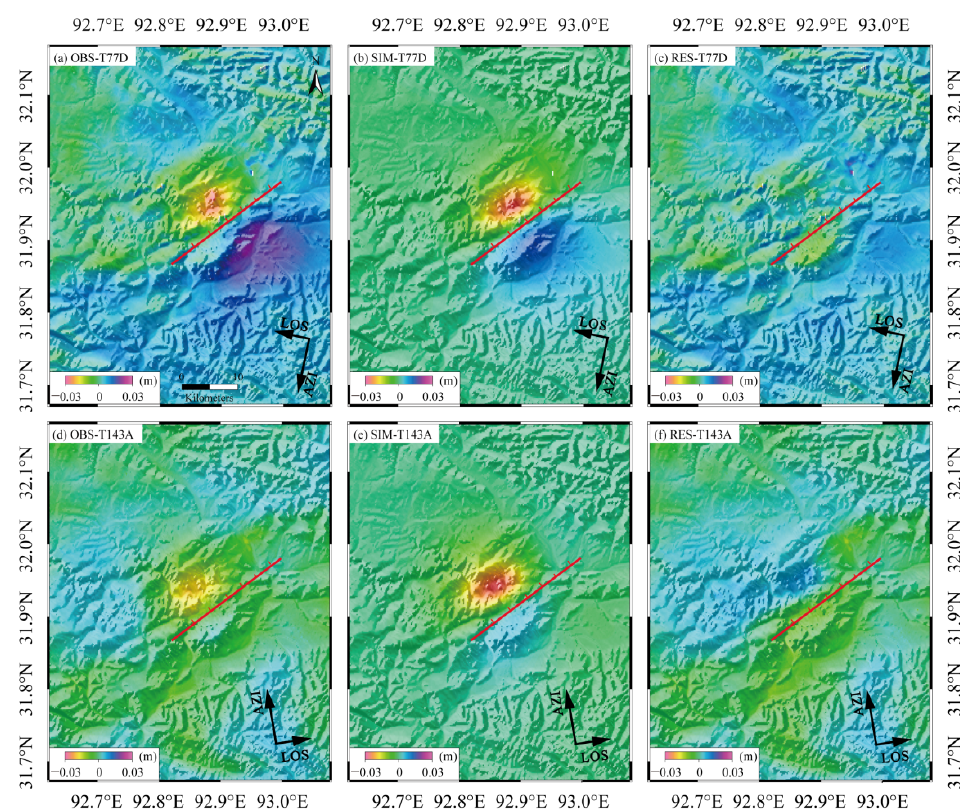
Figure 3. The observed, modeled, and residual interferograms for the InSAR models. ( a , d ) are the observed coseismic interferograms of the descending and ascending tracks, respectively; ( b , e ) are the corresponding modeled data; ( c , f ) are the residuals. In ( a – f ), the red line shows the surface trace of the rupture fault plane.